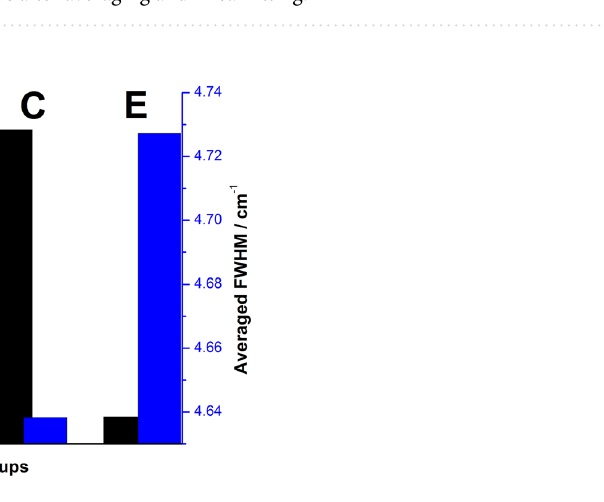
Figure 3. ( a ) Comparative evolution of the FWHM of the main Raman stretching mode of carbonate at 1083 cm –1 for the four groups of otoliths plotted against the distance from core. ( b ) Slope comparison of the FWHM variation of the 4 distinct groups after averaging and linear fitting.